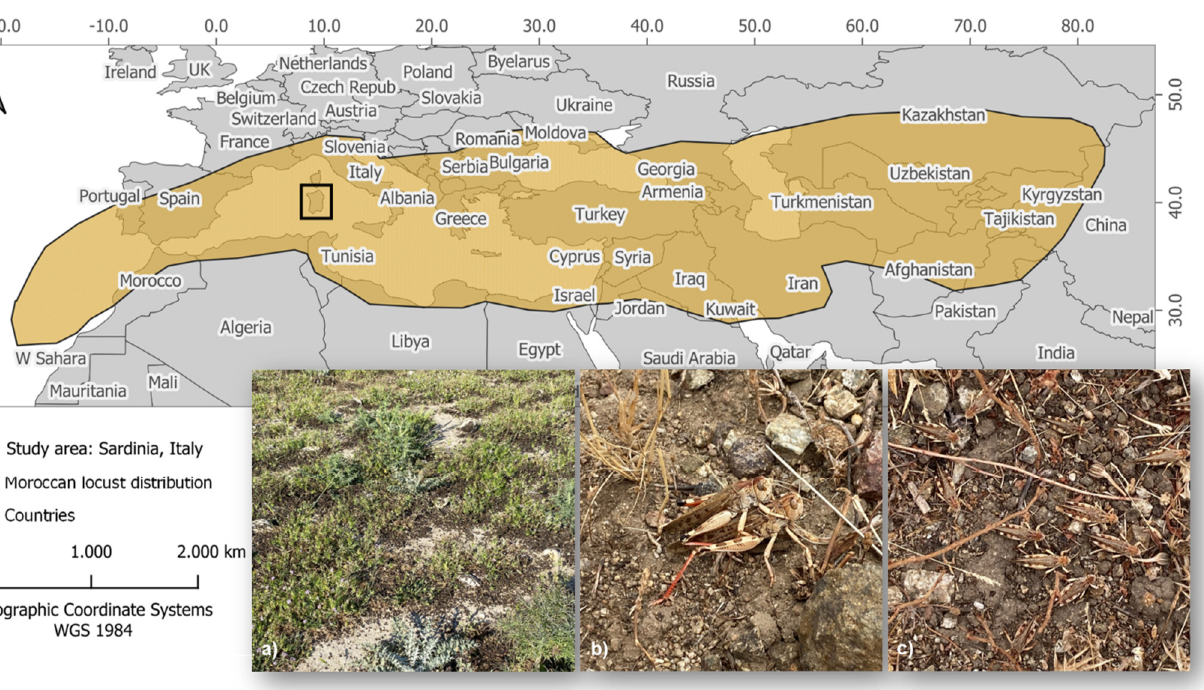
Figure 1. Overview of Moroccan locust distribution (adapted from FAO, 2021): ( a ) band of 1st and 2nd nymph stages of DMA on 26.04.2022 (40.252103 ◦ N, 8.960806 ◦ E); ( b , c ) mating and oviposition on 02.05.2022 (40.244172 ◦ N, 8.983378 ◦ E). Photos © Arturo Cocco.